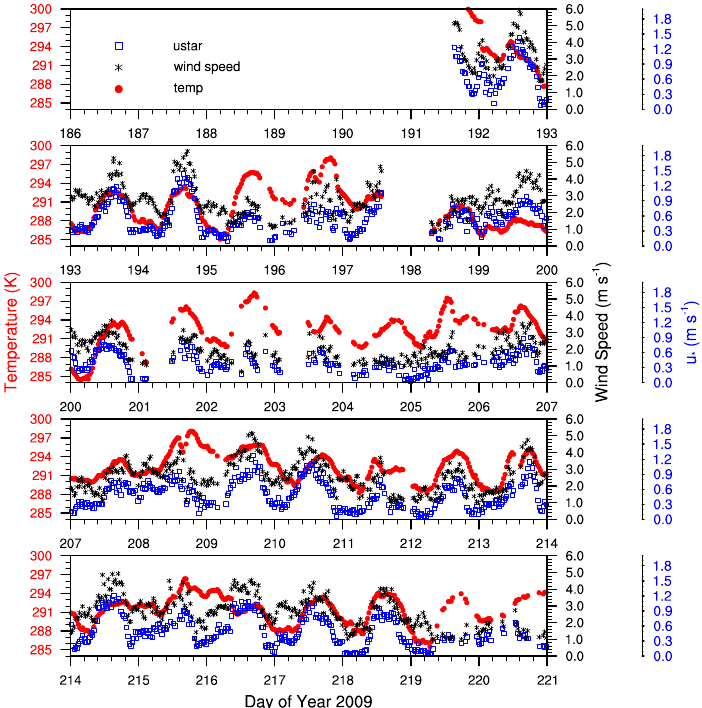
Fig. 3. Time series of filtered meteorological variables from the top sonic anemometer during the 2009 CABINEX campaign (10 July (DOY 191) to 8 August (DOY 220)), including temperature ( T , K; red circles), wind speed ( u , ms − 1 ; black asterisks), and friction velocity ( u ∗ , ms − 1 ; blue open squares).